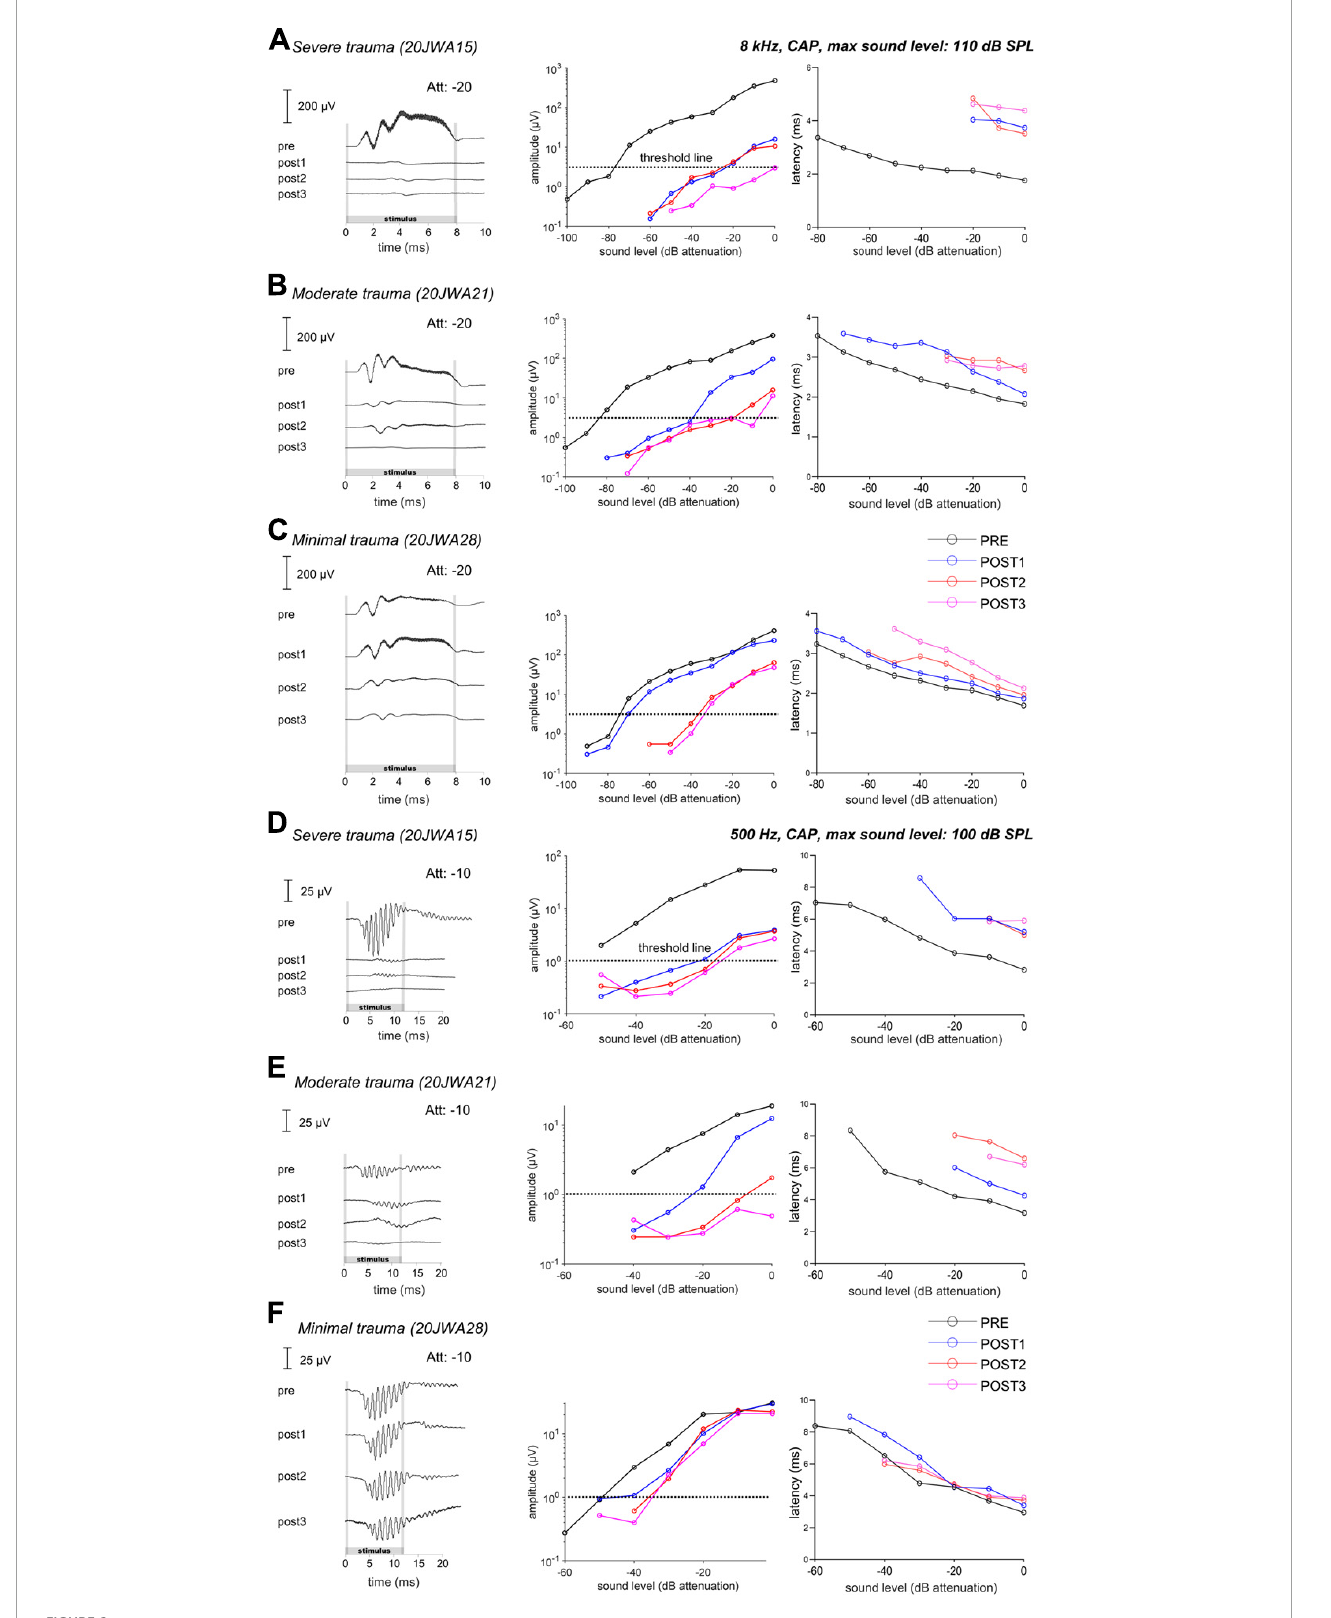
FIGURE6 The CAP responses to an 8 kHz (A–C) and 500 Hz (D–F) tone of three individual animals is shown for all 4 stages. In the upper row (A,D) , the responses of a severely affected animal are shown. It is clear that after cochleostomy the responses were severely affected (high threshold and latency shifts), to both a high and low frequency tone. In the middle row (B,E) , the responses of a moderately affected animal are shown. In this animal, the responses are less severely affected, but still both responses to a low and high frequency were affected. In the lowest row (C,F) , the responses of a minimally affected animal are shown. In this animal, the responses to a high frequency tone are especially affected after electrode-array insertion. Att, attenuation